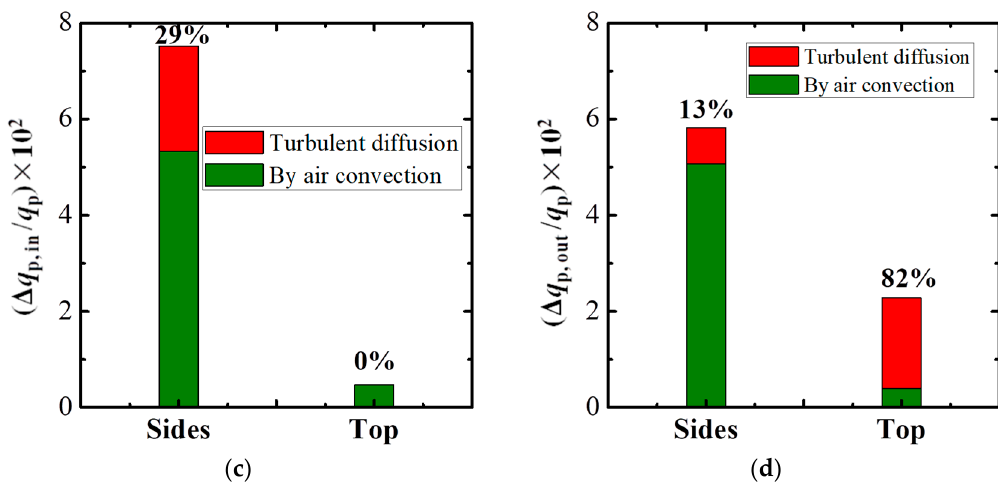
Figure 14. Contributions of air convection and turbulent diffusion to pollutant flow rates at the boundaries of the PSC and TSC (GH-30): ( a ) pollutant inflow rates (PSC); ( b ) pollutant outflow rates (PSC); ( c ) pollutant inflow rates (TSC); ( d ) pollutant outflow rates (TSC). (The percentages in the Figures mean the red bar/total bar).